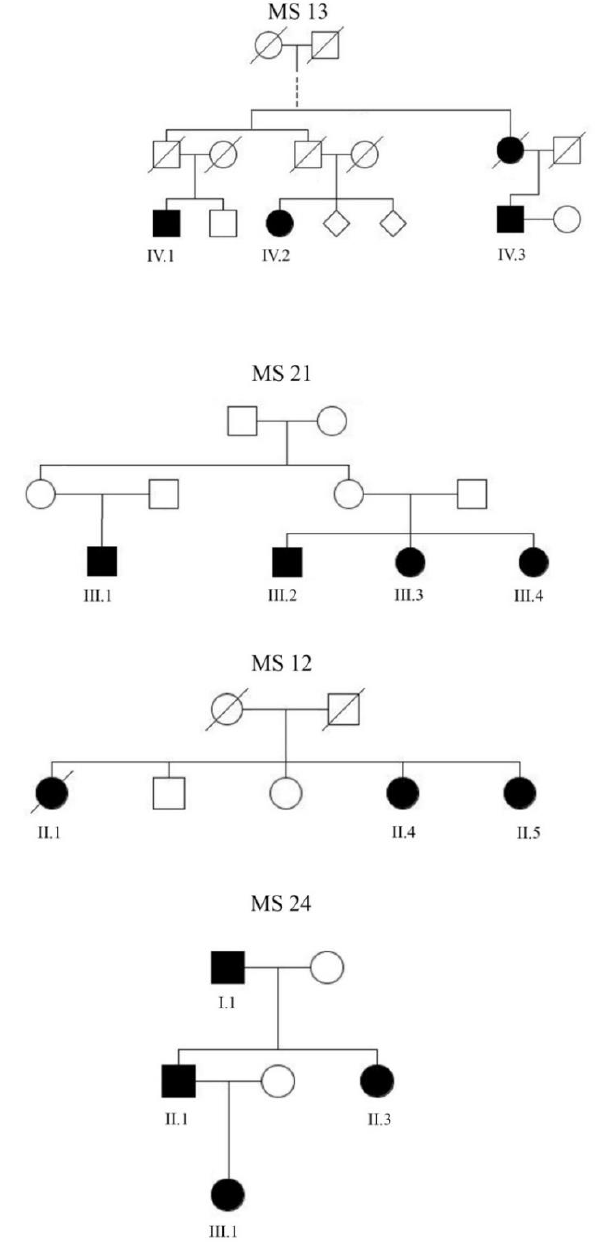
Figure 1. Pedigrees of the 4 families. Men are represented by squares and women by circles. A diagonal line indicates subjects known to be deceased.